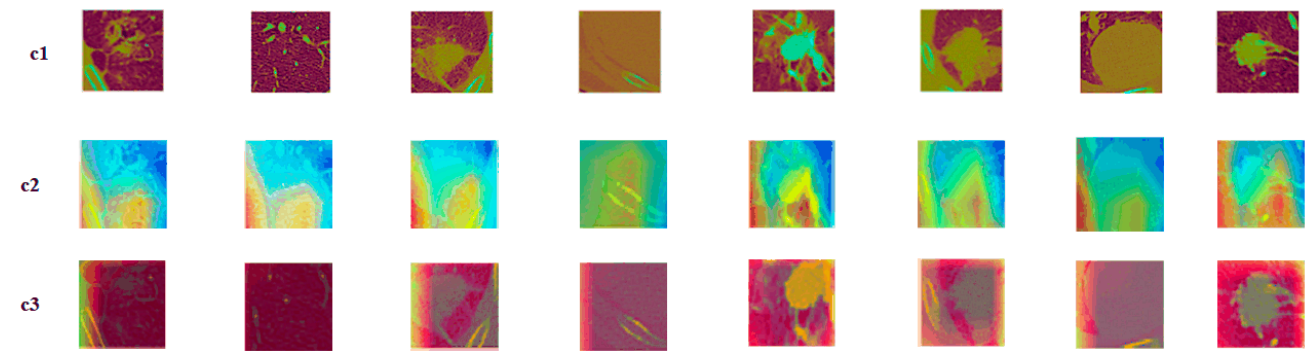
Figure 9. Attention mechanism contrast visualization: ( c1 ) tumor image; ( c2 ) class activation map (CAM) without attention mechanism; ( c3 ) class activation map (CAM) with attention mechanism.